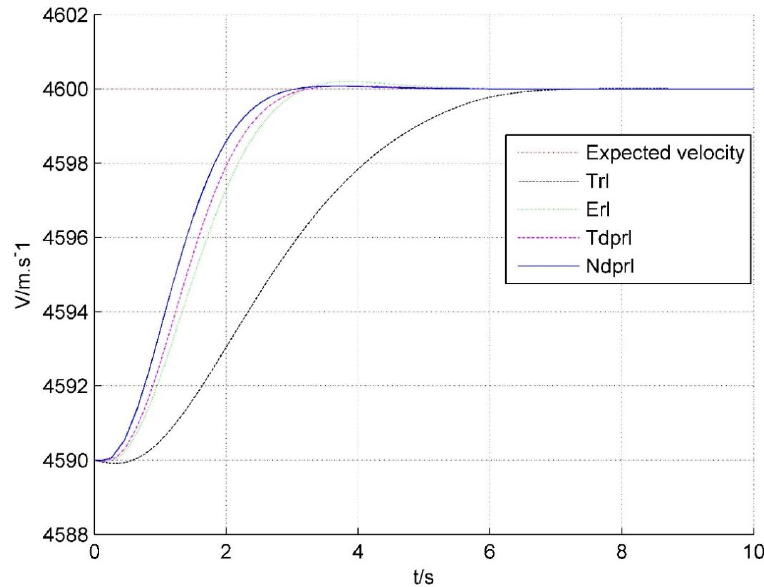
Figure 1. Velocity tracking under reaching laws.